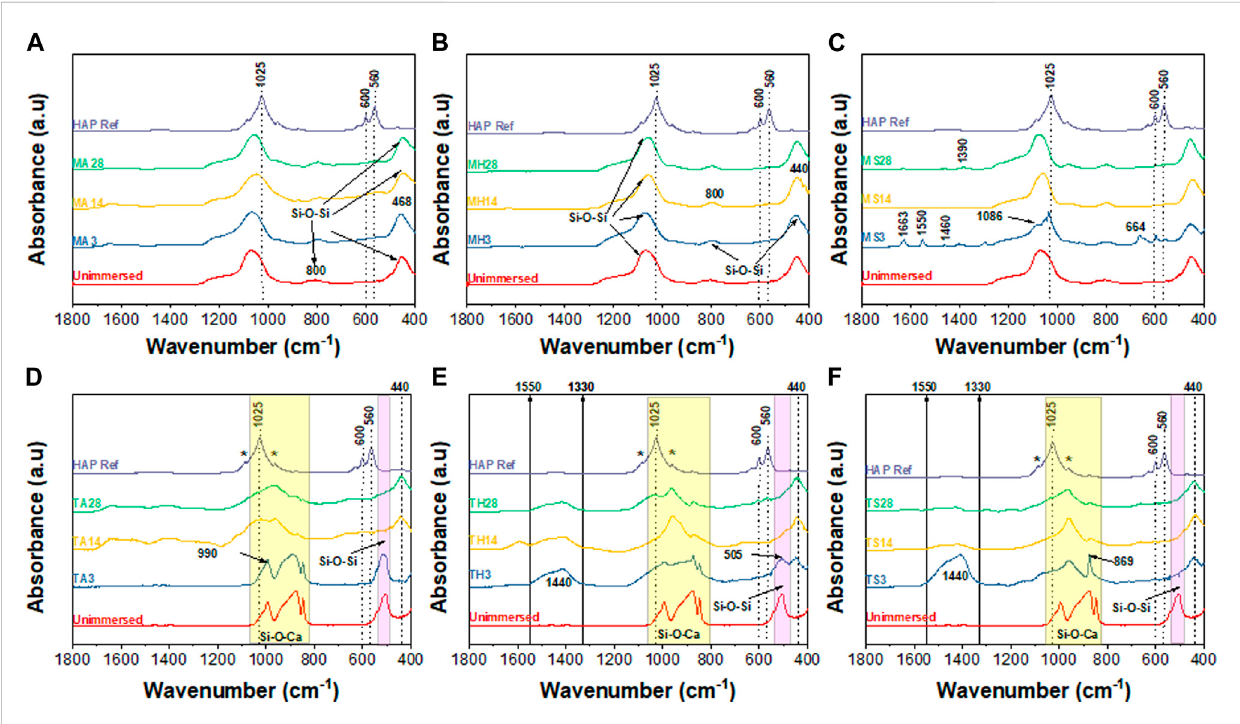
FIGURE 9 Combined FTIRspectra after immersion inthethree media for 3days, 14 days and 28 days. MBGNs inAS (A) , HBSS (B) and SBF (C) and TCS inAS (D) , HBSS (E) and SBF (F)